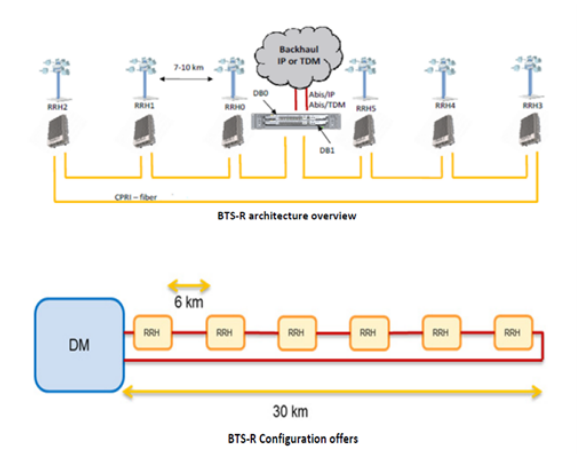
Figure 3. Architecture of distributed technology GSM-R, source: Kontron Transportation